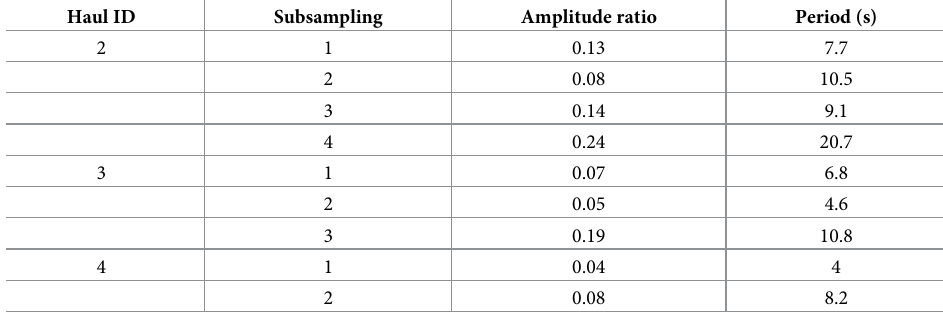
Table 4. Subsample number, amplitude ratio, and period of the shaking codend when tested during sea trials. Haul ID